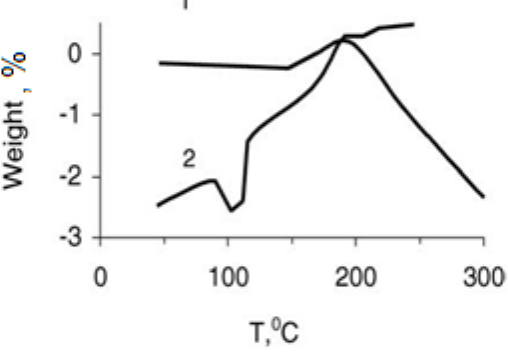
Figure 3. Weight loss (% of the binder) (curve 1) and differential thermal assay (curve 2) of the SHMPE +Y Ba Cu O . The composition of the composite: 1 2 3 6.97 SHMP:Y Ba Cu O = 20:80 (in mass ratio of the monomer). Heating rate is 1 2 3 6.97 3.2 ° C/min [19].